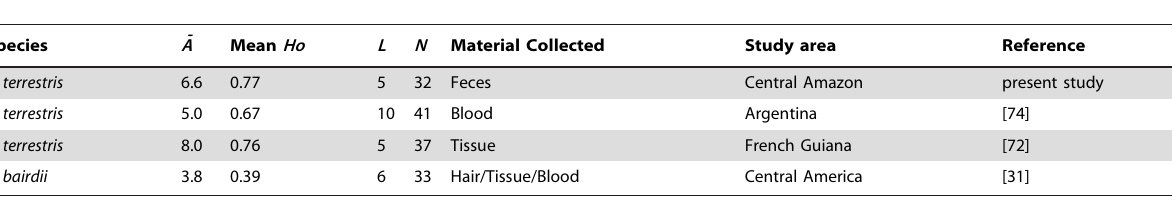
Table 4. Studies that measured tapir genetic variability from microsatellite markers.